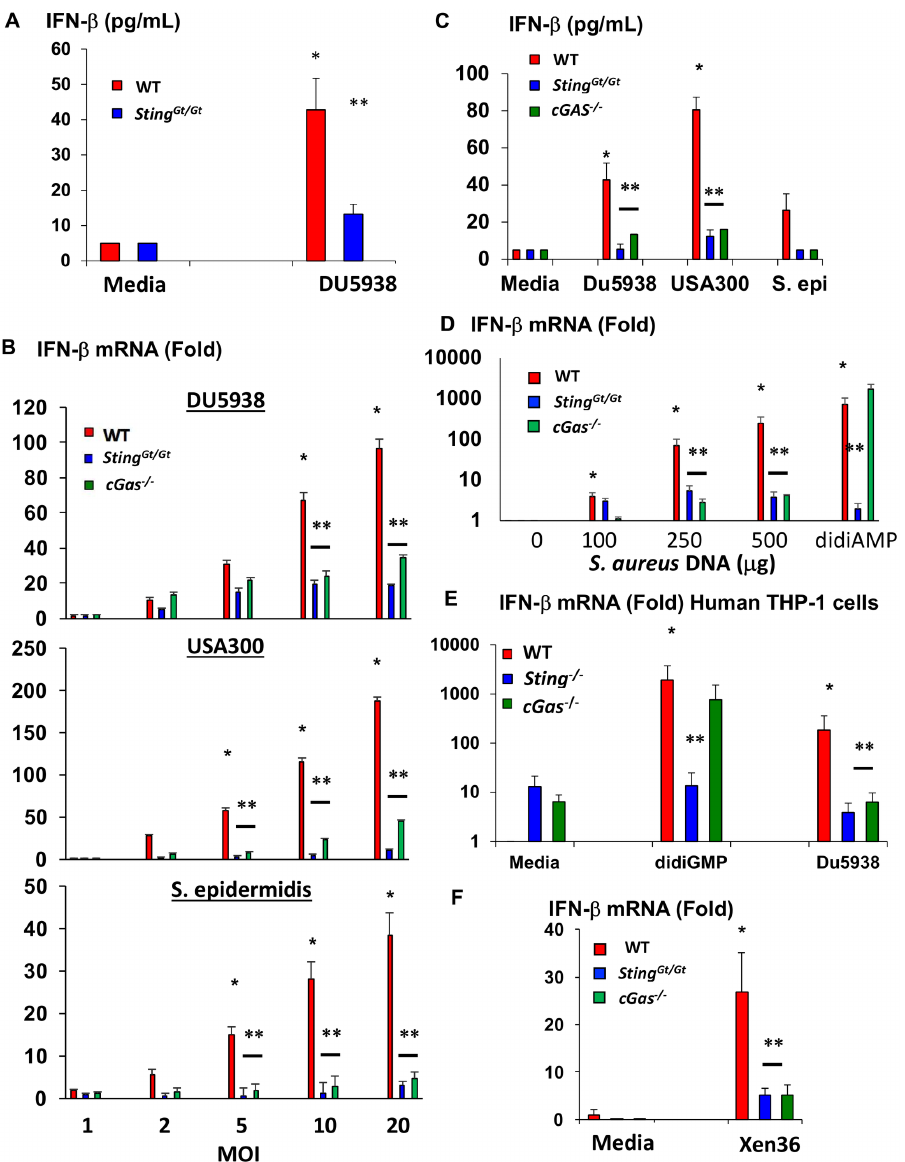
Fig 5. Multiple strains of staphylococcus induce IFN- β in mouse and human cells through the cGAS-STING pathway. (A) IFN- β productionby BMDMs generatedfrom WT and Sting Gt/Gt mice after 4 hours stimulation with MOI 10 of strain DU5938 of S . aureus . Data shown is from individualsamples from 3 separateexperiments. (B) qPCR of mouse WT, Sting Gt/Gt , and cGAS -/- BMDM stimulated with increasing MOI of the indicatedspecies of staphylococcal organism. Experiments were performed in triplicate, and representative of two separateexperiments. (C) IFN- β production by BMDMs generatedfrom WT, Sting Gt/Gt , and cGas -/- mice followinga 4 hour treatment with an MOI 10 of DU5938 or a USA300 (JE2) strains of S . aureus (n = 3), or the same MOI of S . epidermidis (n = 2). (D) IFN- β qPCR followingtreatment of mouse macrophages with highlypurifiedDNA from USA300(JE2) strain of S . aureus grown overnightintroduced intracellularly with lipofectamine for 4 hours or treated with 10 mM of the STING activator di-cyclic AMP (didiAMP). (E) IFN- β qPCR following4 hour treatment of WT humanTHP-1 cells or THP-1 cells with CRISPR/ Cas9 mediateddeletionof STING or cGAS with di-cyclic GMP (1ug/ml) or an MOI 10 of DU5938of S. aureus for 4 hours. (F) IFN- β qPCR following4-hour treatment of mouse BMDMs with an MOI of 10 of the bioluminescent Xen36 S . aureus strain. For all above * denotesp < 0.05by one way ANOVA with Tukey test comparedto baselinecontrol. ** denotesp < 0.05from WT stimulatedmacrophages at the same time point with the same stimulationby one way ANOVA with Tukey test. All error bars denote standarderror of the